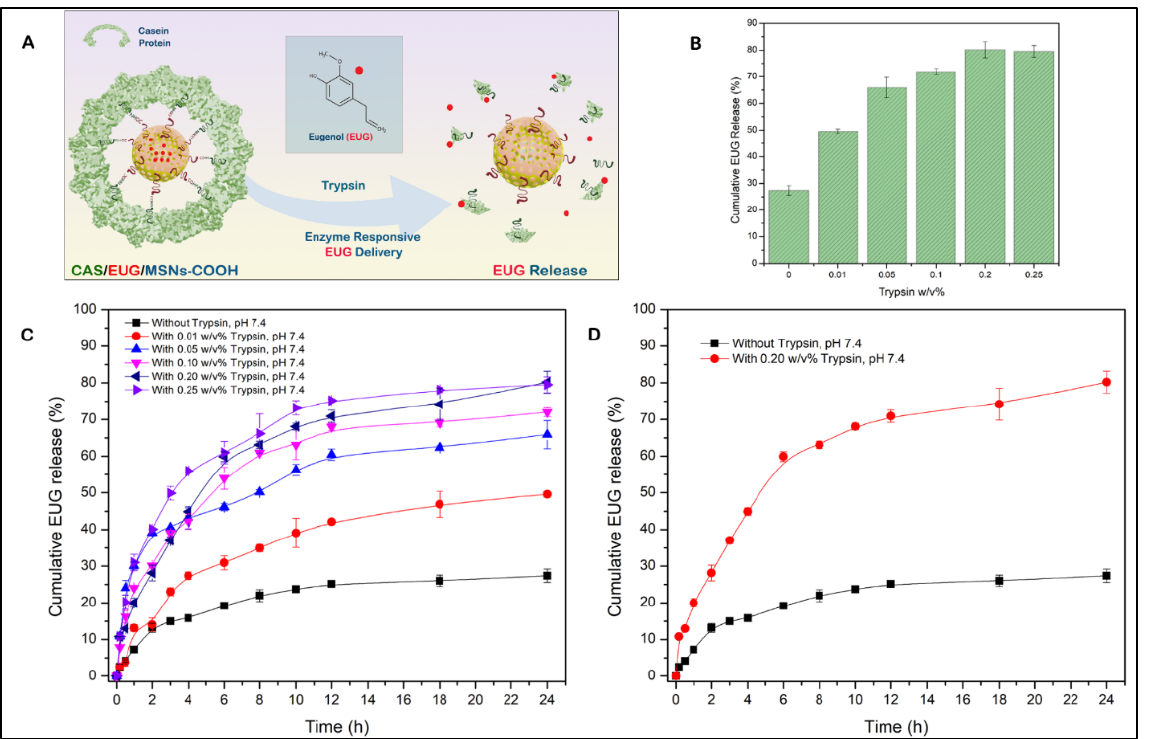
Figure 9. ( A ) Release of an anticancer drug, EUG, which is triggered by trypsin that cleaves a gatekeeping component (casein) of the EUG/CAS-MSNs–COOH, ( B ) The cumulative release of EUG for 24 h at pH 7.4, RT at different w / v % of trypsin from the MSN–COOH pore channels, ( C ) Cumulative release (%) profiles of EUG from EUG/CAS-MSNs–COOH with and without trypsin at different w / v % (pH 7.4, RT) for 24 h. The black curve represents EUG release profiles from the EUG/MSNs–COOH in the absence of trypsin at pH 7.4, RT, ( D ) Cumulative release (%) profiles of EUG from EUG/CAS-MSNs–COOH in the presence of the 0.20 w / v % trypsin mixture (optimized concentration) (red curve) and the absence of any enzymes from casein-capped MSNs–COOH (black curve) at pH 7.4, RT. Each data point represents the mean of the experiments performed in triplicate and their corresponding standard deviation.